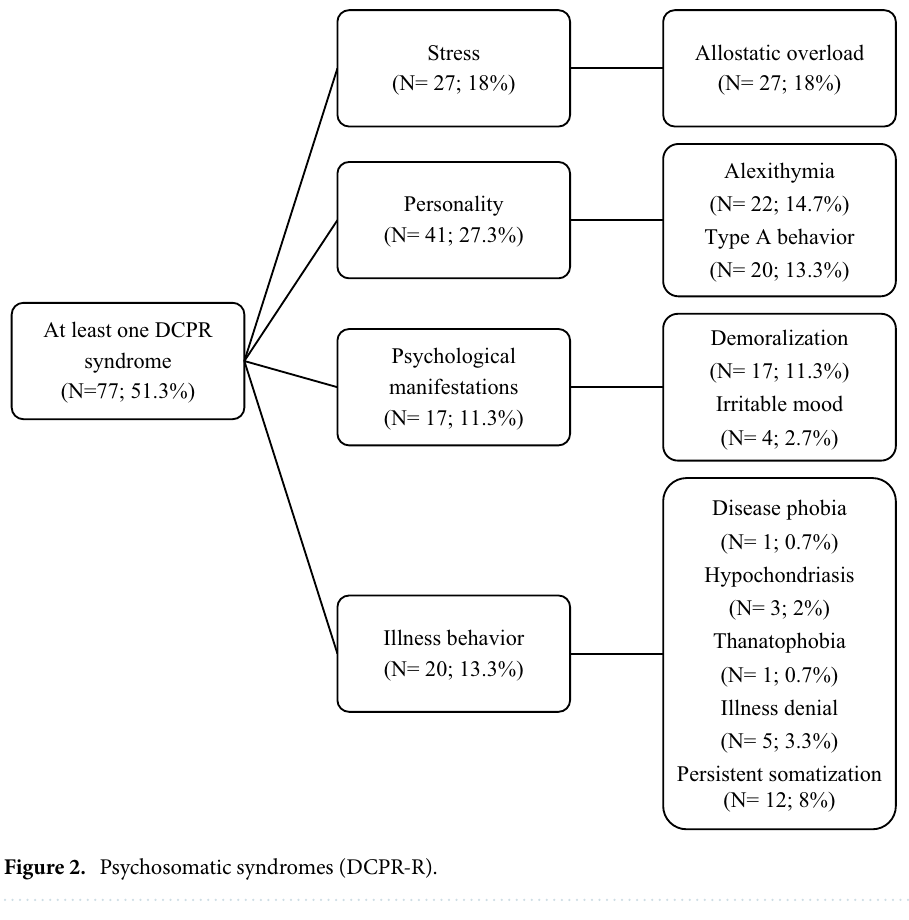
Figure 2. Psychosomatic syndromes (DCPR-R).